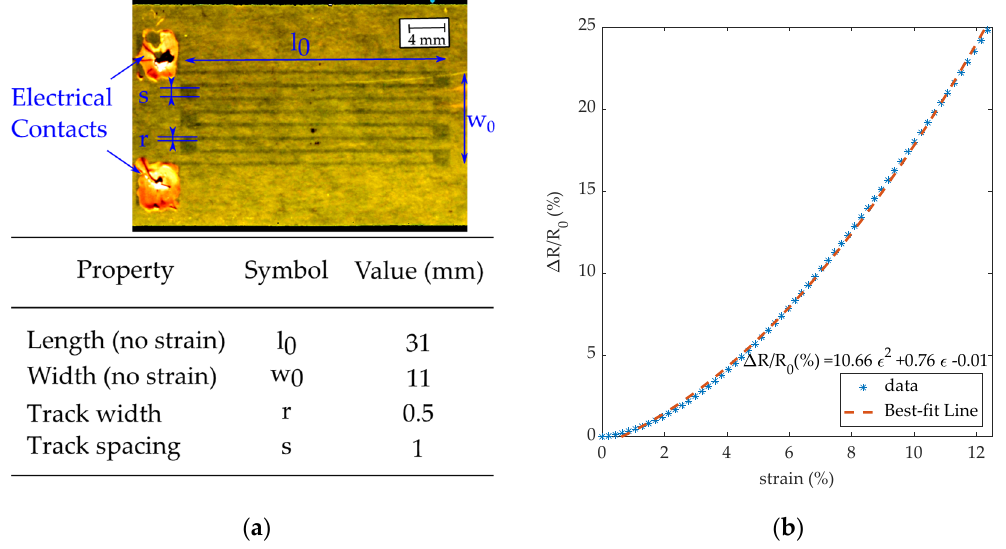
Figure 4. ( a ) Printed strain gauge. ( b ) Strain–resistance curve, where R 0 is the resistance with no strain.